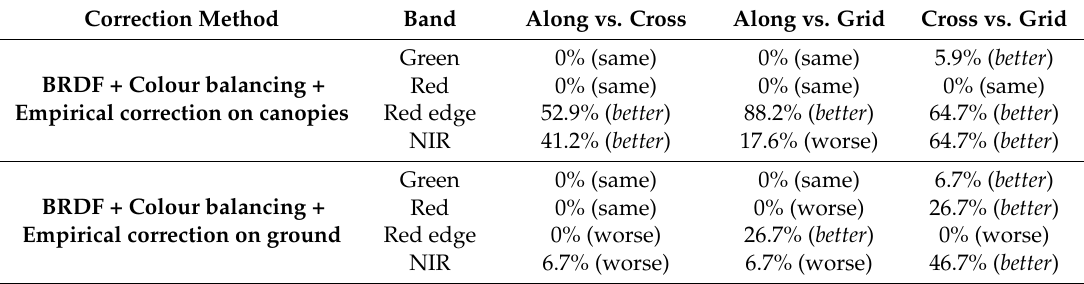
Table 1. Reflectance consistency percentages between different flight patterns in dataset 2.